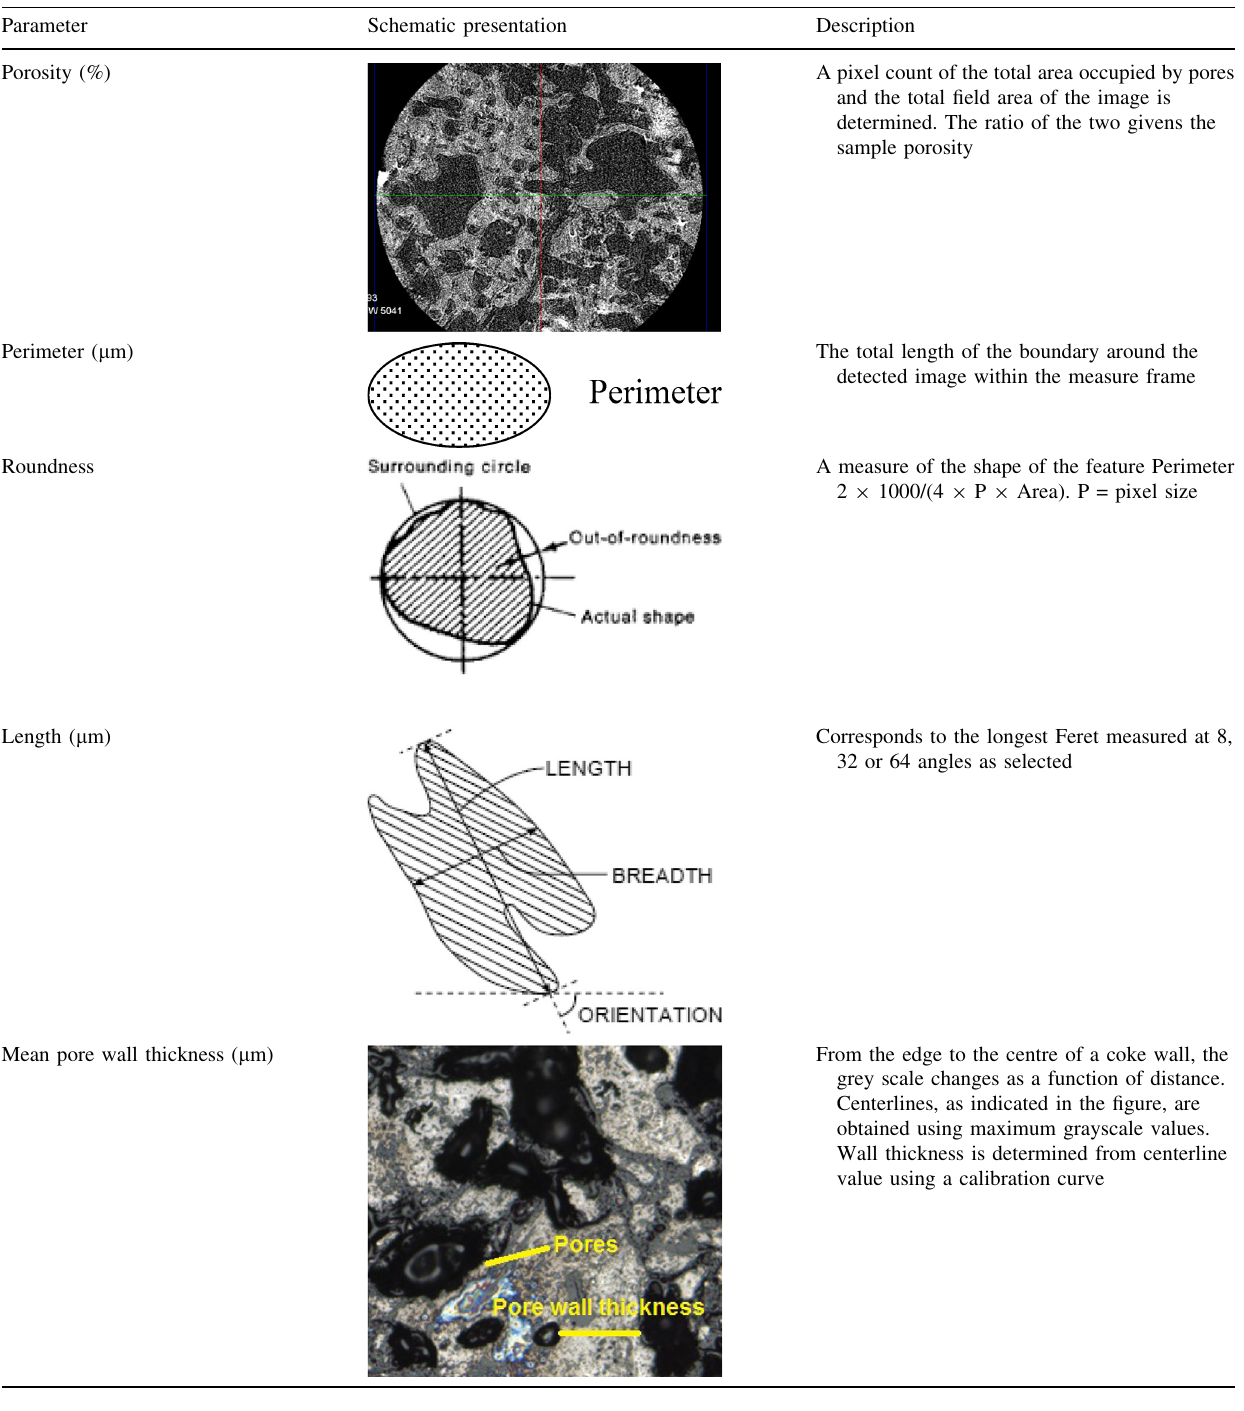
Table 3 Schematic diagram for coke structure parameters description Parameter Schematic presentation